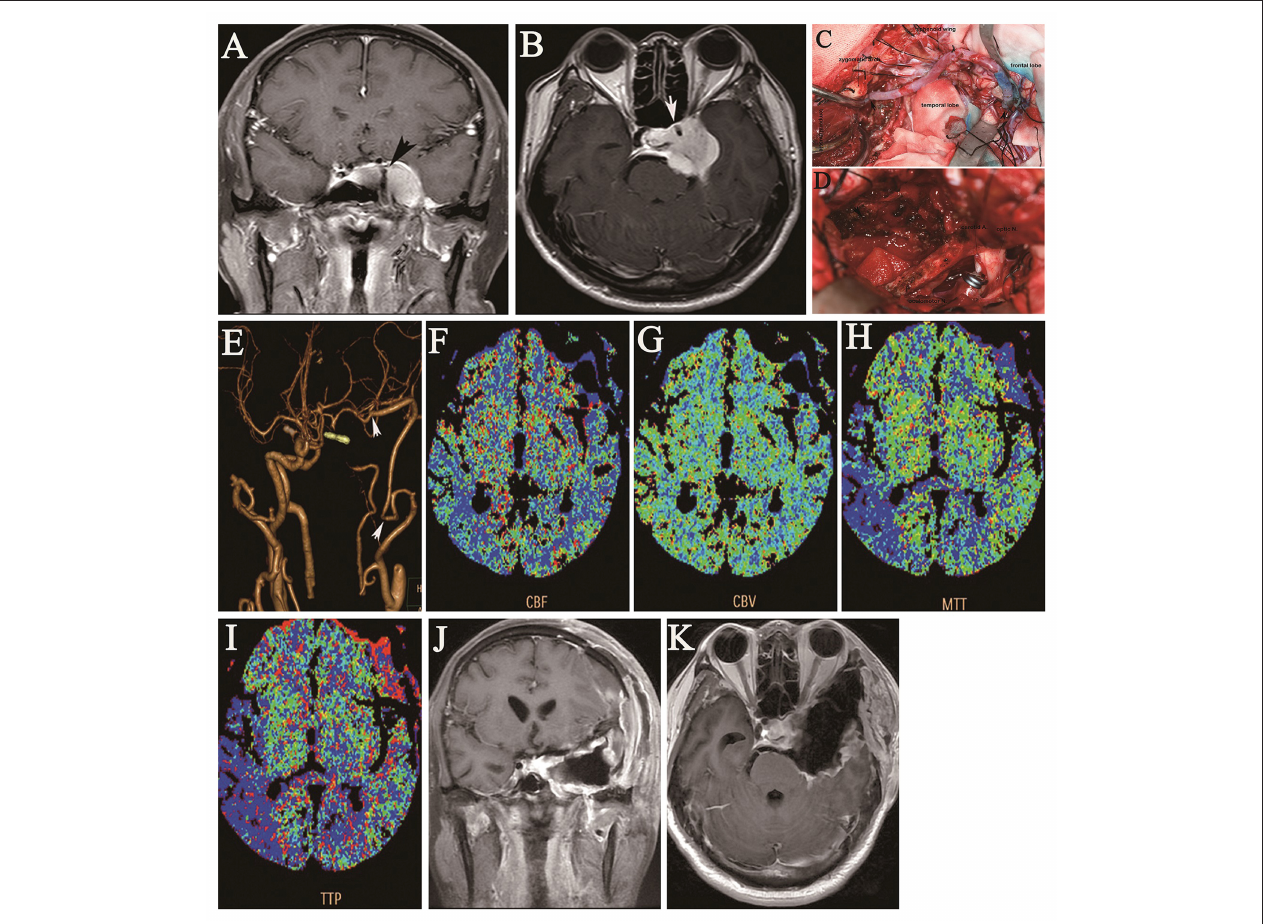
FIGURE 1 | A 46-year-old man presented with a 7-year history of double vision and left-sided facial numbness for 1 year and ptosis for half a year. Coronal (A) and axial (B) preoperative contrast-enhanced MRI shows a large tumor in the cavernous region encasing the ICA (A) , as indicated by the arrow. Intraoperative images show end-to-end anastomosis of the IMA to the RA and end-to-side anastomosis of the M2 segment of the MCA through a frontotemporal craniotomy with resection of the zygomatic arch (C) , the operative field of the cavernous region (as indicated by the arrow), and the clipped supraclinoid ICA after total tumor resection (D) . Postoperative CTA shows the patency of the IMA bypass with the RA graft and occlusion of the left ICA; the arrows indicate the anastomotic sites of the RA graft (E) . Postoperative CT perfusion imaging shows the (F) cerebral blood flow, (G) cerebral blood volume, (H) mean transit time, and (I) time-to-peak for the left cerebral hemisphere after IMA bypass, which is consistent with symmetry in the hemodynamic capacity of the right cerebral hemisphere. Coronal (J) and axial (K) contrast-enhanced MRI at the 2-year follow-up shows no tumor growth in the cavernous